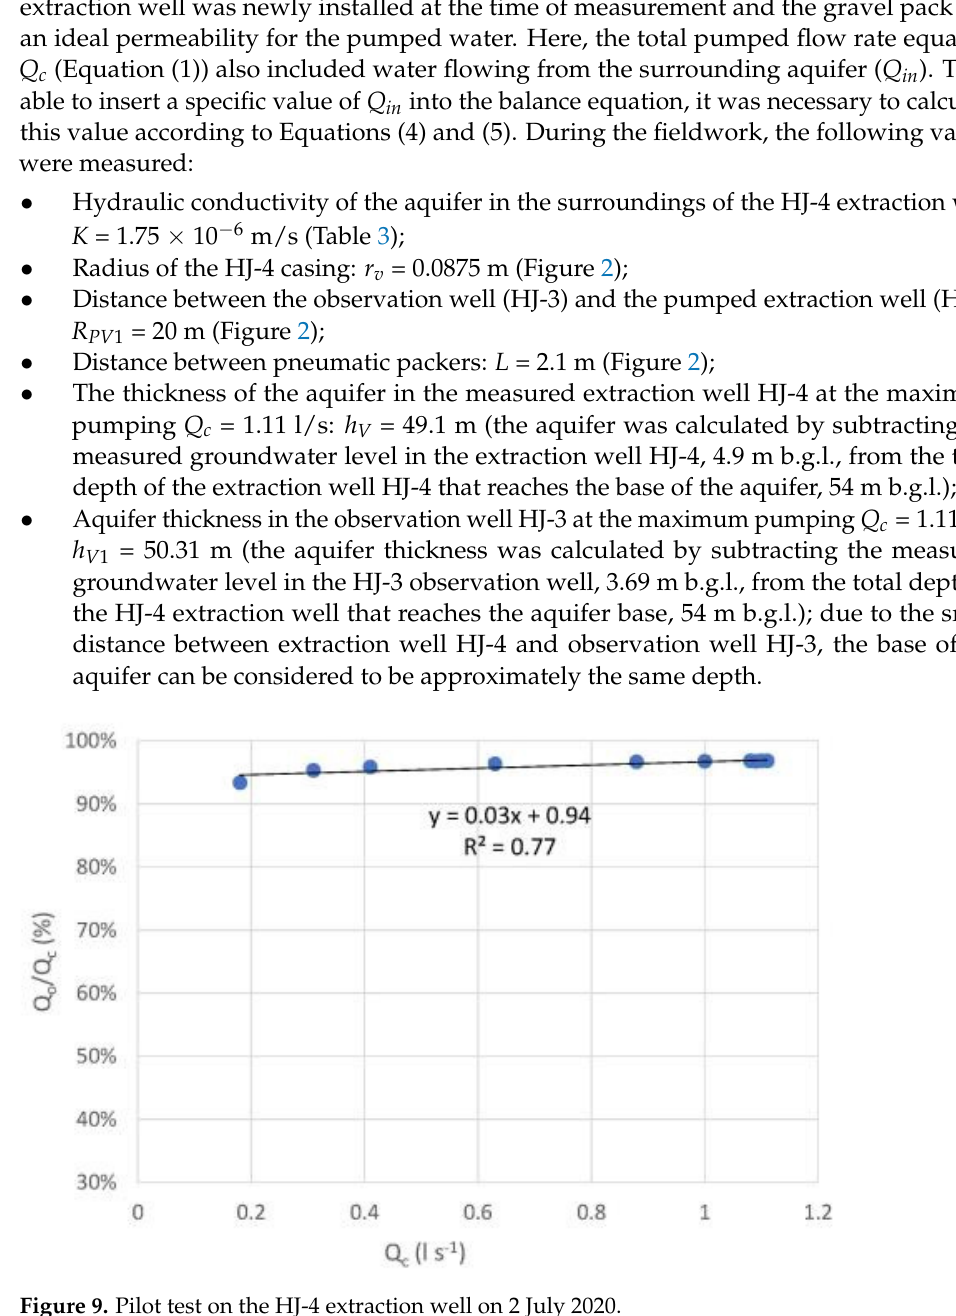
Figure 9. Pilot test on the HJ-4 extraction well on 2 July 2020.